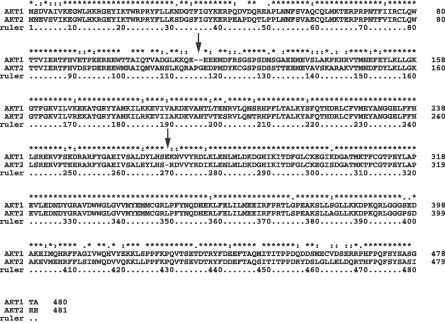
Sequence Alignment between Akt-1 and Akt-2 Kinase Domain